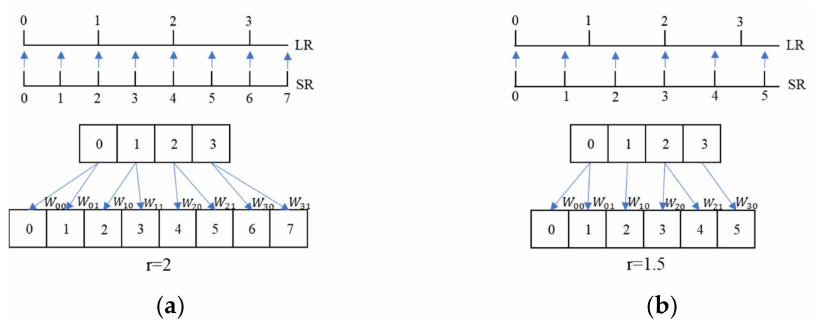
Figure 6. Pixel mapping schematic diagram. ( a ) r = 2; ( b ) r = 1.5.